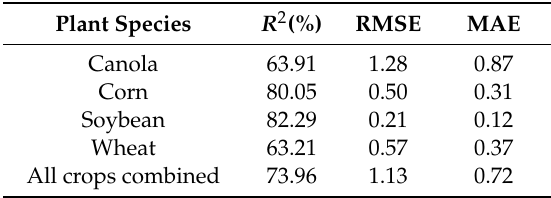
Table 3. Five-fold cross-validation results of water. The average of the metrics from the five folds is reported.